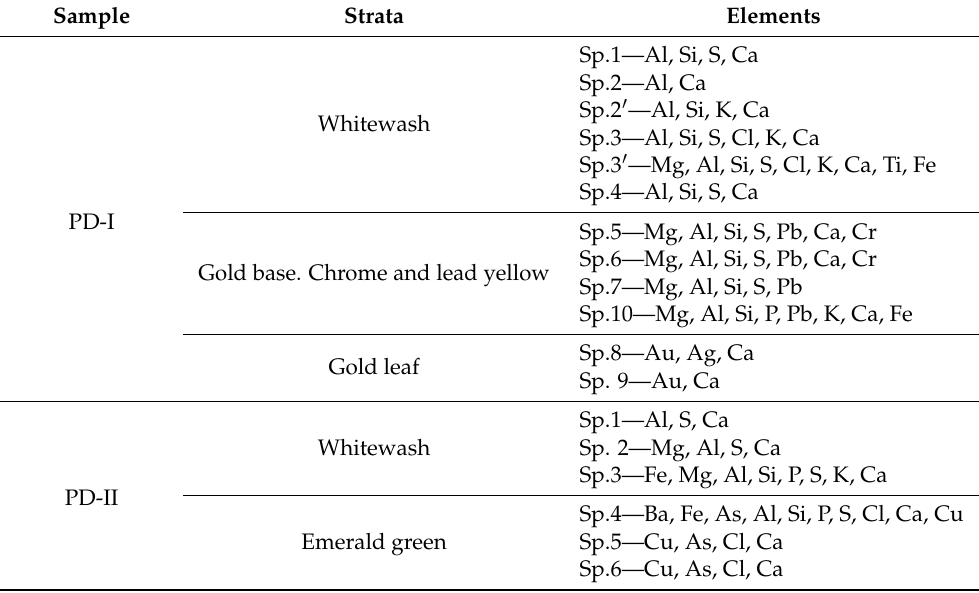
Figure 6. SEM images of PD-II taken in backscattered electron mode (BSE) (left) and emerald green polychromy identified by the characteristic spherulitic forms. Numbers 1 to 6 correspond to points analysis whose results are in Table 2. Table 2. Chemical composition of PD-I and PD-II determined by SEM-EDX.